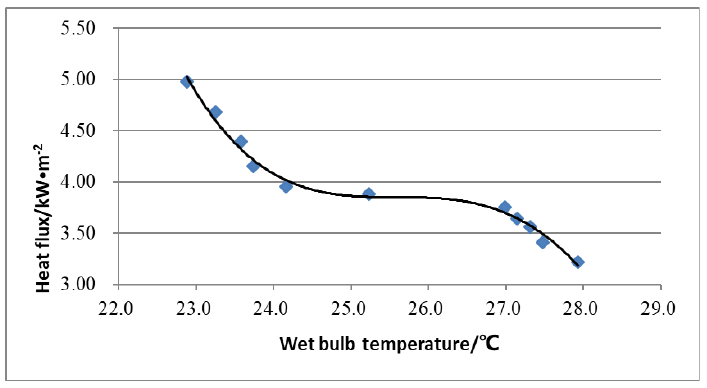
Figure 8. Variation trend of heat flux for the vertical CECT with ambient wet bulb temperature.